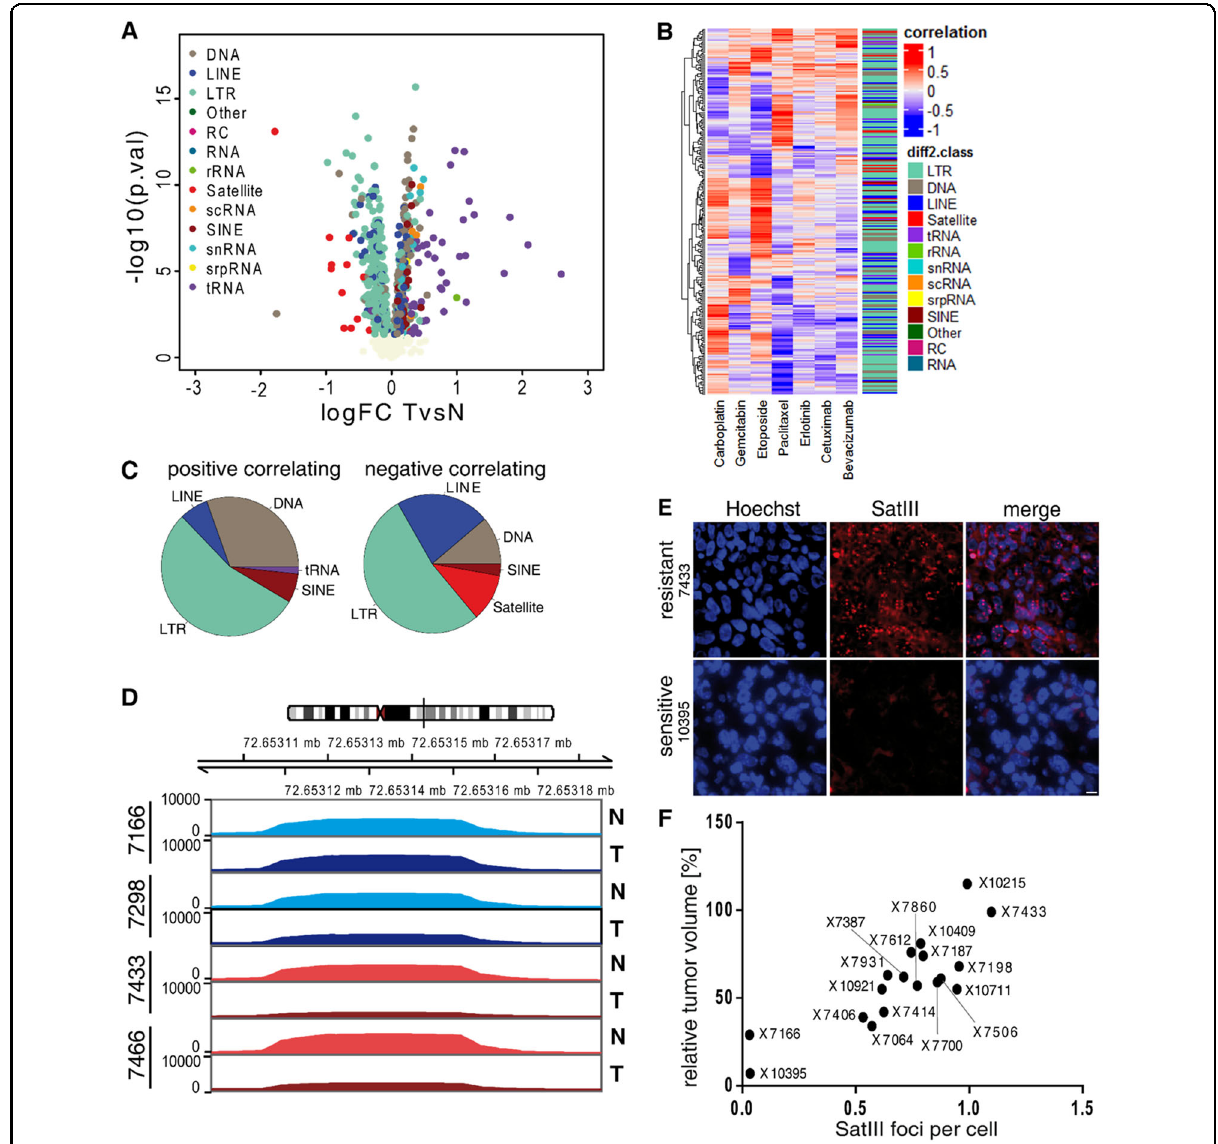
Fig. 1 Hypomethylation of pericentromeric satellite repeats correlates with etoposide resistance in non-small cell lung cancer PDX mouse models. A Volcano plot shows the global methylation changes at repetitive elements between 22 patient-derived NSCLC xenograft tumor samples and their corresponding normal tissue (TvsN). Each dot represents one repetitive element, based on the RepeatMasker database, classi fi ed into subclasses (color code). The log fold change of methylation in tumor versus normal tissue is plotted on the x-axis, the y-axis shows the negative log 10 of the p -value. B Heatmap shows the Pearson ’ s correlation between the sensitivity of the PDXs (measured by the differential methylation between tumor and normal tissues) with the chemotherapeutics indicated by the column name. The adjacent bar indicates the repetitive region class. C Composition of the signi fi cantly correlated ( p -value < 0.05) repeats classes: positive (left) and negative (right) correlations between response to Etoposide and differential methylation. D Methylation levels of two etoposide sensitive PDXs (7166 and 7298; green) and two etoposide resistant PDX models (7433 and 7466; red) at the Satellite III DNA locus on chromosome 9. Lighter colors represent the coverage of normal tissue (N), darker colors show the coverage of tumor samples (T). E RNA FISH staining of Satellite III transcripts (SatIII RNA) in FFPE tumor material of untreated etoposide resistant (7433) and etoposide sensitive (10395) PDX mice. The tissue was stained with SatIII RNA FISH probes (red) as well as Hoechst stain 33342 (blue). Scale bar, 10 µm. F Correlation of SatIII RNA foci and the relative tumor volume on native FFPE PDX tumor tissue. SatIII RNA foci were stained with SatIII RNA FISH, quanti fi ed, and set into relation to the response rate towards etoposide.